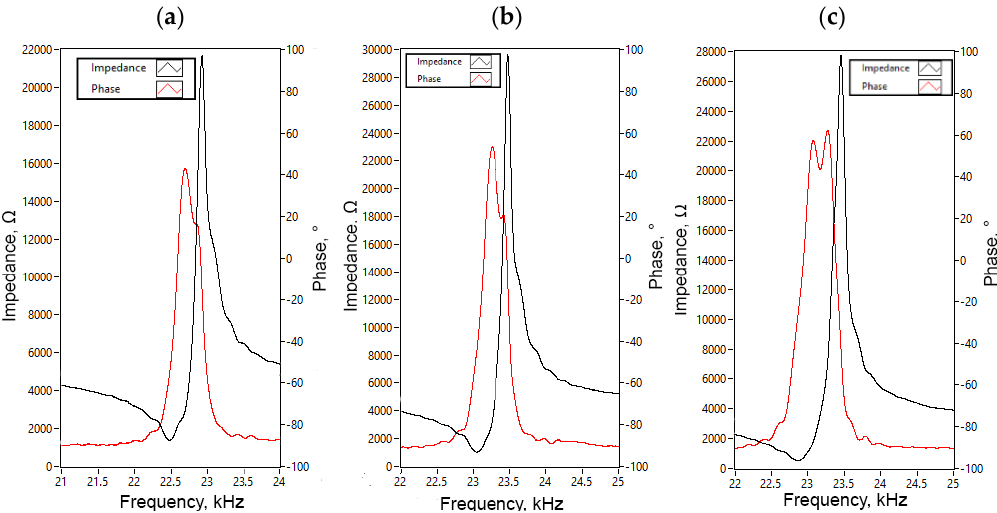
Figure 14. Impedance and phase frequency characteristics of the platform; ( a )—characteristics of Plate 1 ; ( b )—characteristics of Plate 2 ; ( c )—characteristics of Plate 3 .